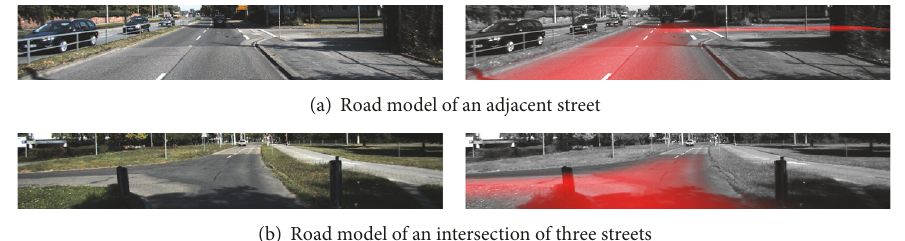
Figure 15: Road prior obtained after modeling the uncertainty of the vehicle position and